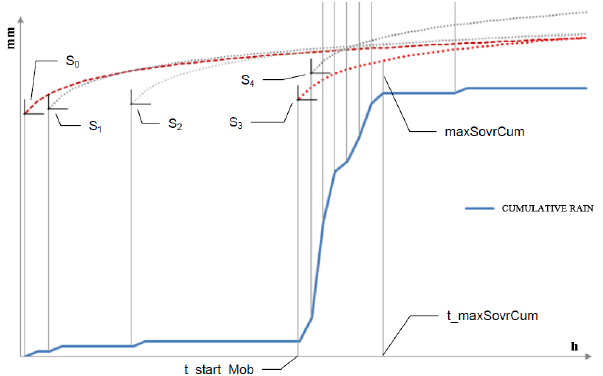
Figure 5. Example of the functioning of the algorithm that shifts the initial time of the rainfall until the highest hazard is identified: S1 to S4 are four examples of shifted starting time; maxSovrCum is the maximum value exceeding the threshold (or minimum distance from the threshold when not exceeded) (mm); t_maxSovrCum is the time of occurrence of maxSovrCum; and t_start_Mob is the starting time to be considered to obtain the highest value of